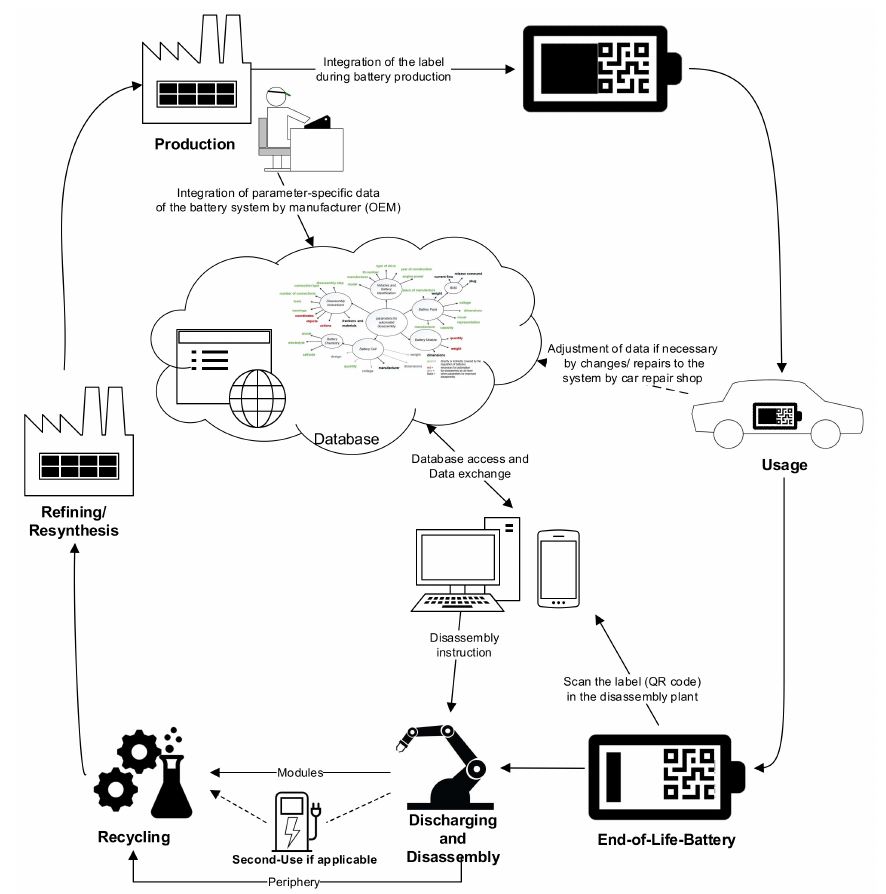
Figure 15. Proposal for a labeling